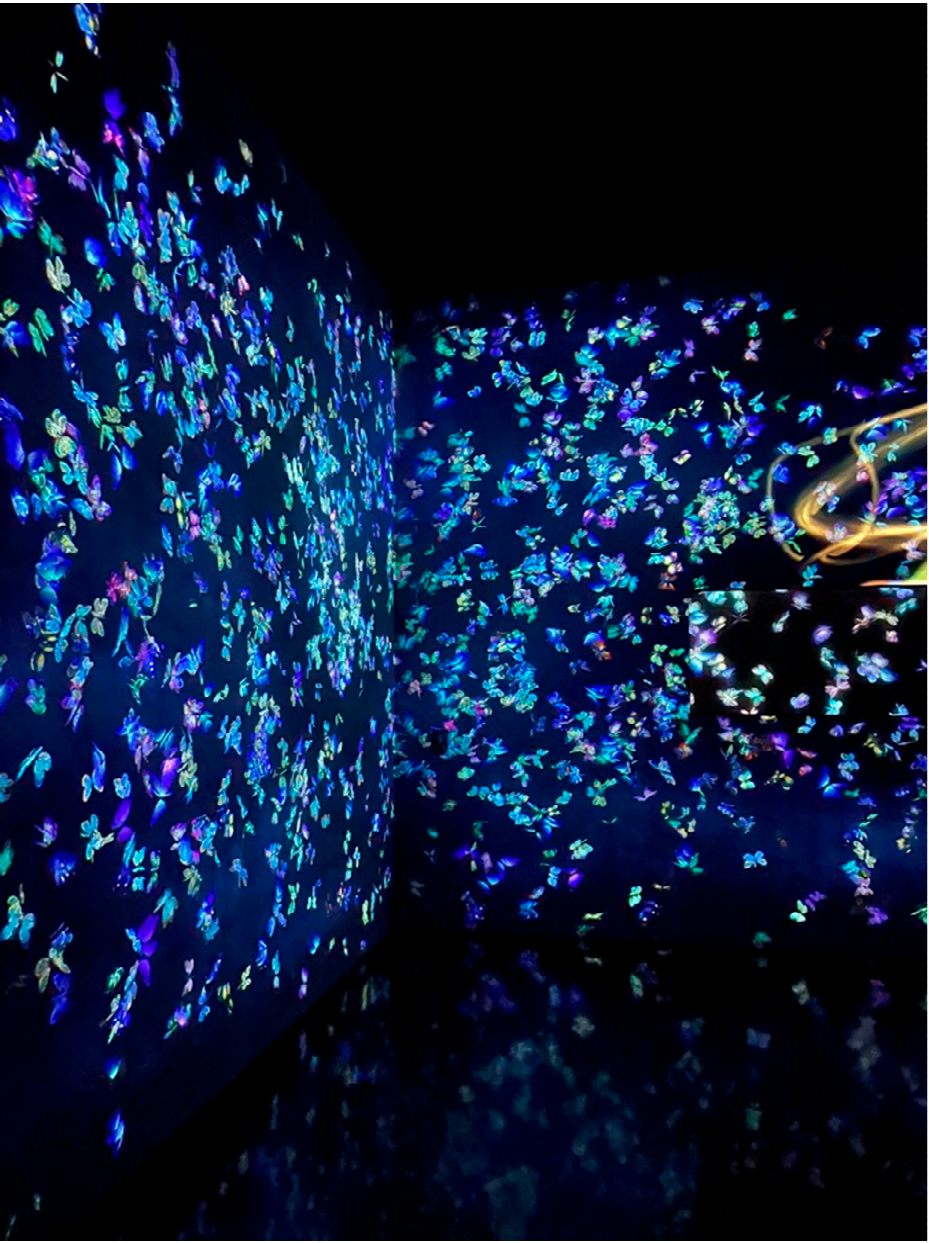
Figure 10. teamLab, Flutter of Butterflies Beyond Borders, Ephemeral Life, 2015/2021 in The Void, 2016/2021, Asian Art Museum of San Francisco; photograph by the author, 2022.